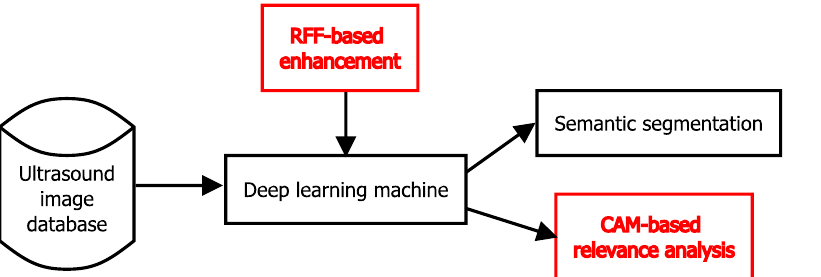
Figure 3. Nerve structure segmentation 2D from ultrasound images pipeline. FCN, U-net, and ResUnet architectures (see Section 2.1) are enhanced using an RFF-based layer (see Section 2.2). The predicted mask (nerve vs. background) and a class activation mapping (CAM)-based image (see Section 2.3) can be obtained as outputs.